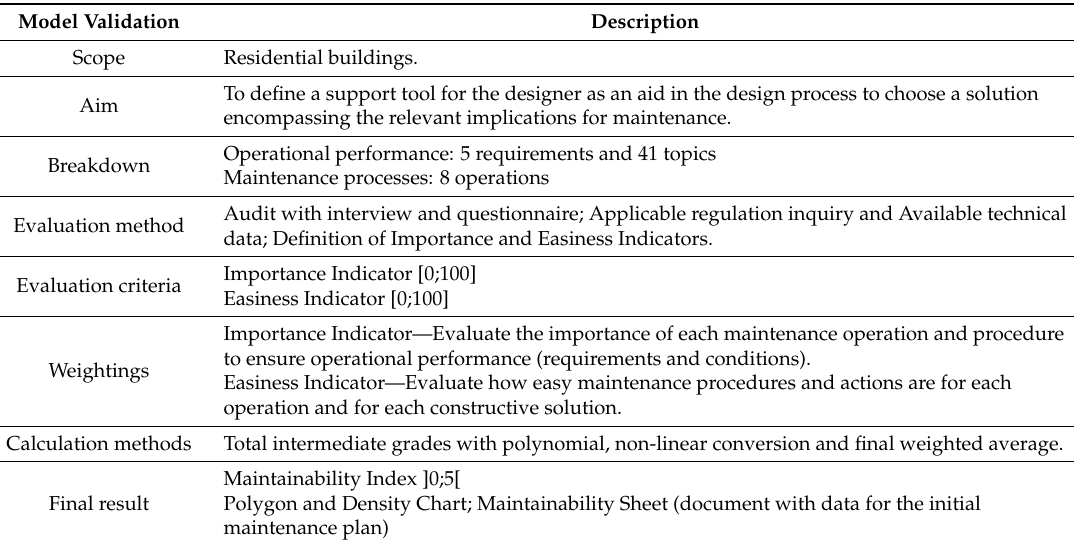
Table 5. Model summary